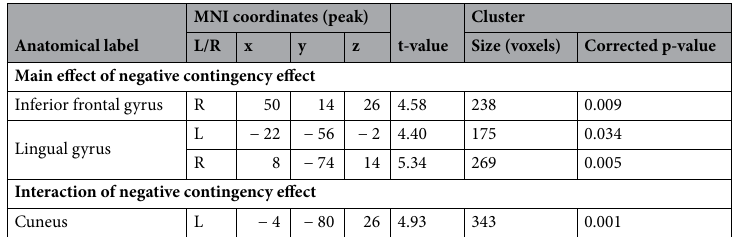
Table 2. Brain regions represent a negative contingency effect in the recognition phase. Peaks were obtained from the negative contingency effect contrast (i.e., [FN + ON] > [FC + OC] for the main effect of contingency and [FN − ON] > [FC − OC] the interaction between contingency and face perception). The threshold for significant activation was initially set at P < 0.001 (uncorrected), and then corrected to P < 0.05 for multiple comparisons based on cluster size. The other details are similar to those presented in Table 1.